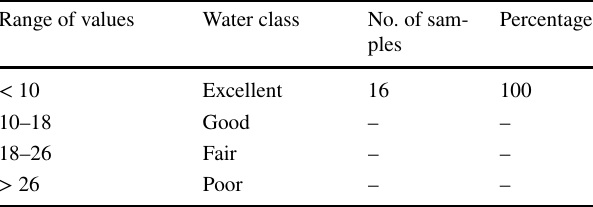
Table 6 Suitability of groundwater for irrigation purpose based